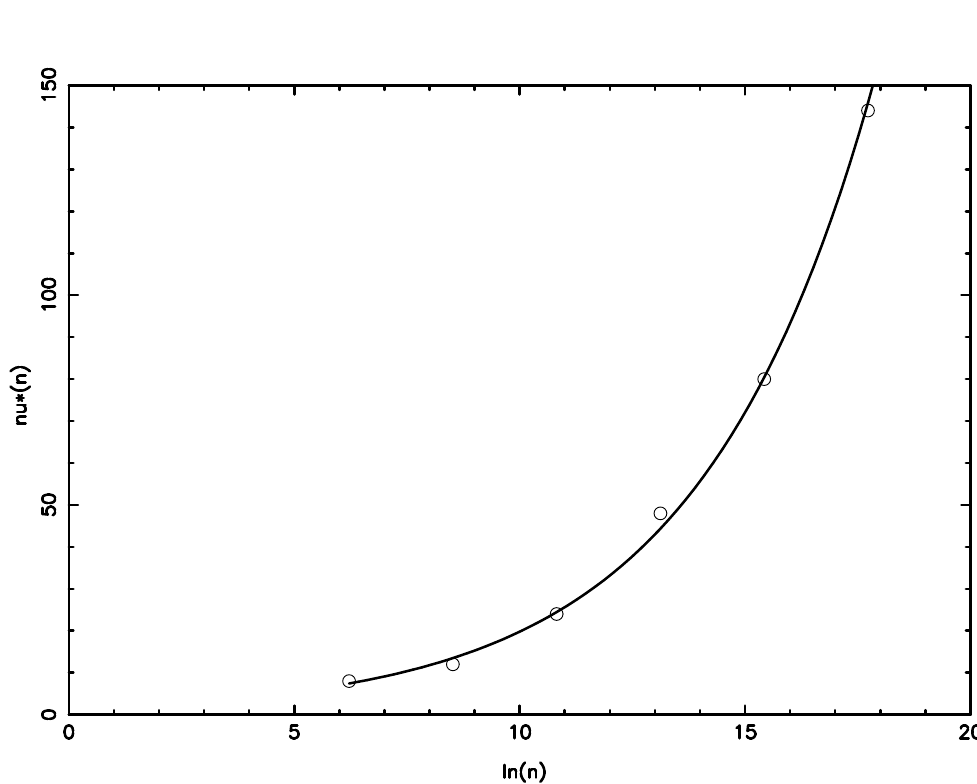
Figure 3: ν ∗ vs. ln ( n ) . Circles: computed values, continuous line: approximation n ν ∗ = µ exp ( λ ln ( n )) for 2 10 2 ≤ n ≤ 5 10 7 . n